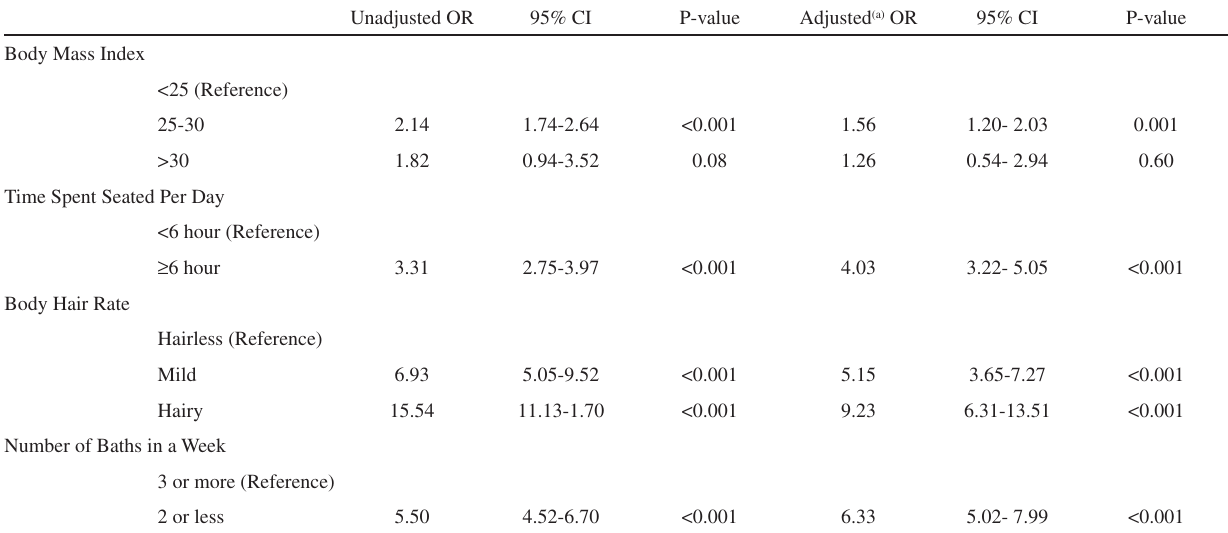
Table 2- Effects of various variables on pilonodial disease based on univariate statistics and multivariate logistic regression analysis Unadjusted OR 95% CI